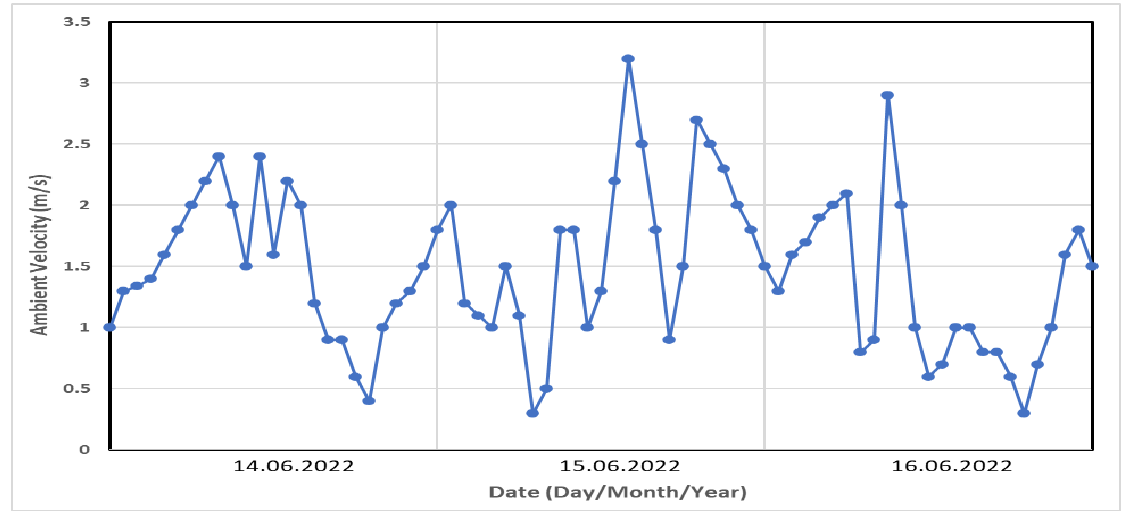
Figure 7. Variations in global irradiance, temperature, and relative humidity of ambient air during experiments.